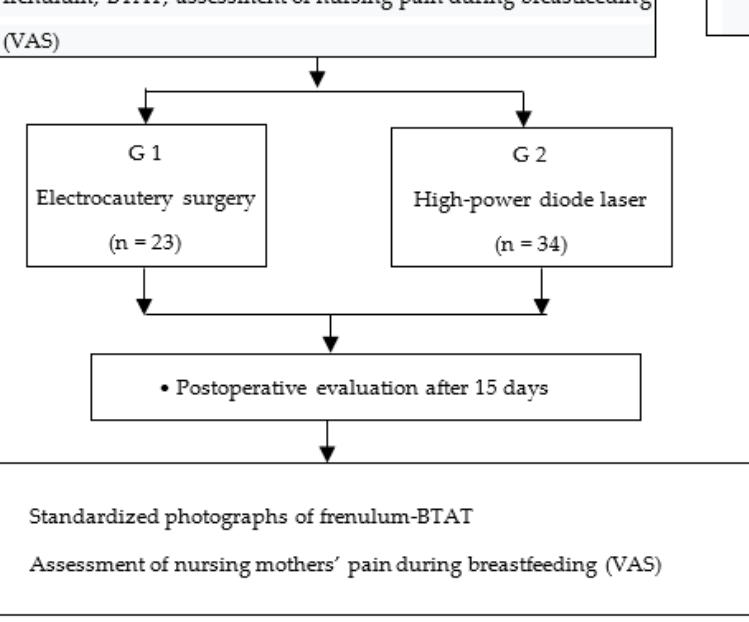
Figure 1. Clinical study flowchart.